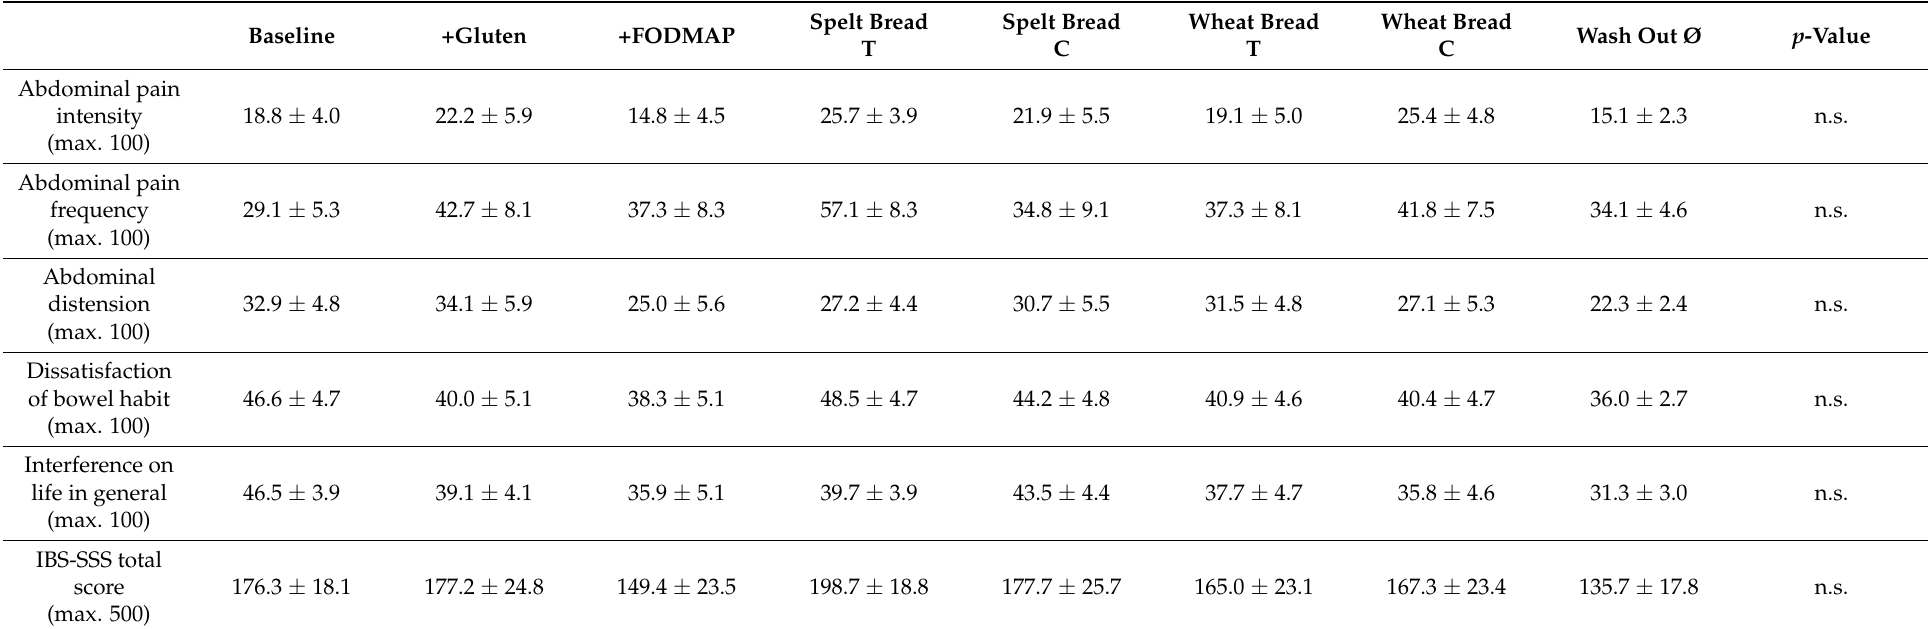
Table 3. Results of Irritable Bowel Syndrome—Severity Scoring System